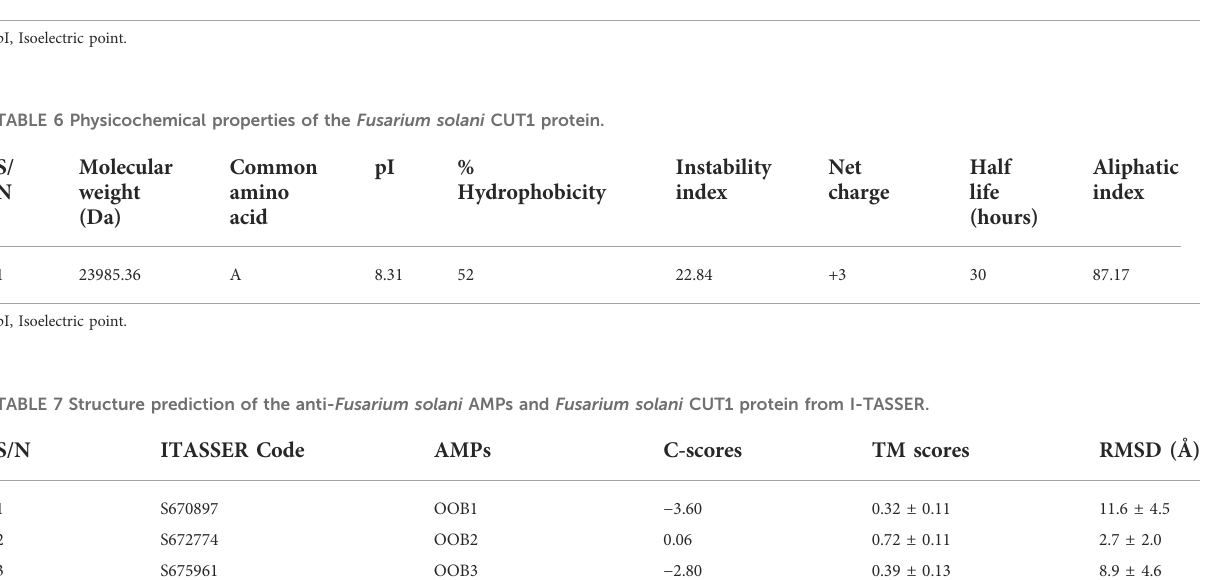
pI, Isoelectric point.